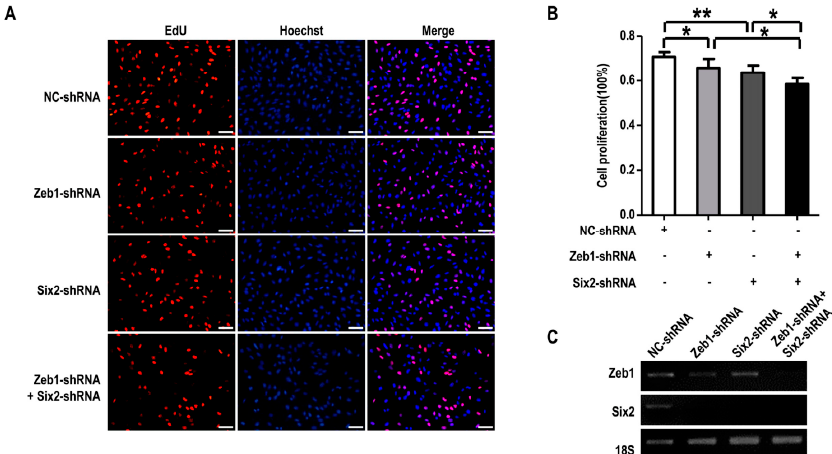
Figure 6. Zeb1 is required for the proliferation of mK3 cells associated to Six2 . ( A ) mK3 cells were 48 h post-introduced with control shRNA, Zeb1 -shRNA, Six2 -shRNA or both of the two target shRNA. Then EdU assay was performed refering to Figure 2 and the red and blue images were merged to the purple ones; the length of scale bar was 50 μ m. Cell proliferation was decreased in mK3 cells treated with either single shRNA or double shRNA of Zeb1 and Six2 compared with respective controls; ( B ) The data of proliferation percentage (EdU %) were presented as mean ± SD ( n = 3). * p < 0.05, ** p < 0.01, respective controls; ( C ) The significant knock-down efficiency of Zeb1 and Six2 was measured by the RT-PCR with the internal control 18S equal.